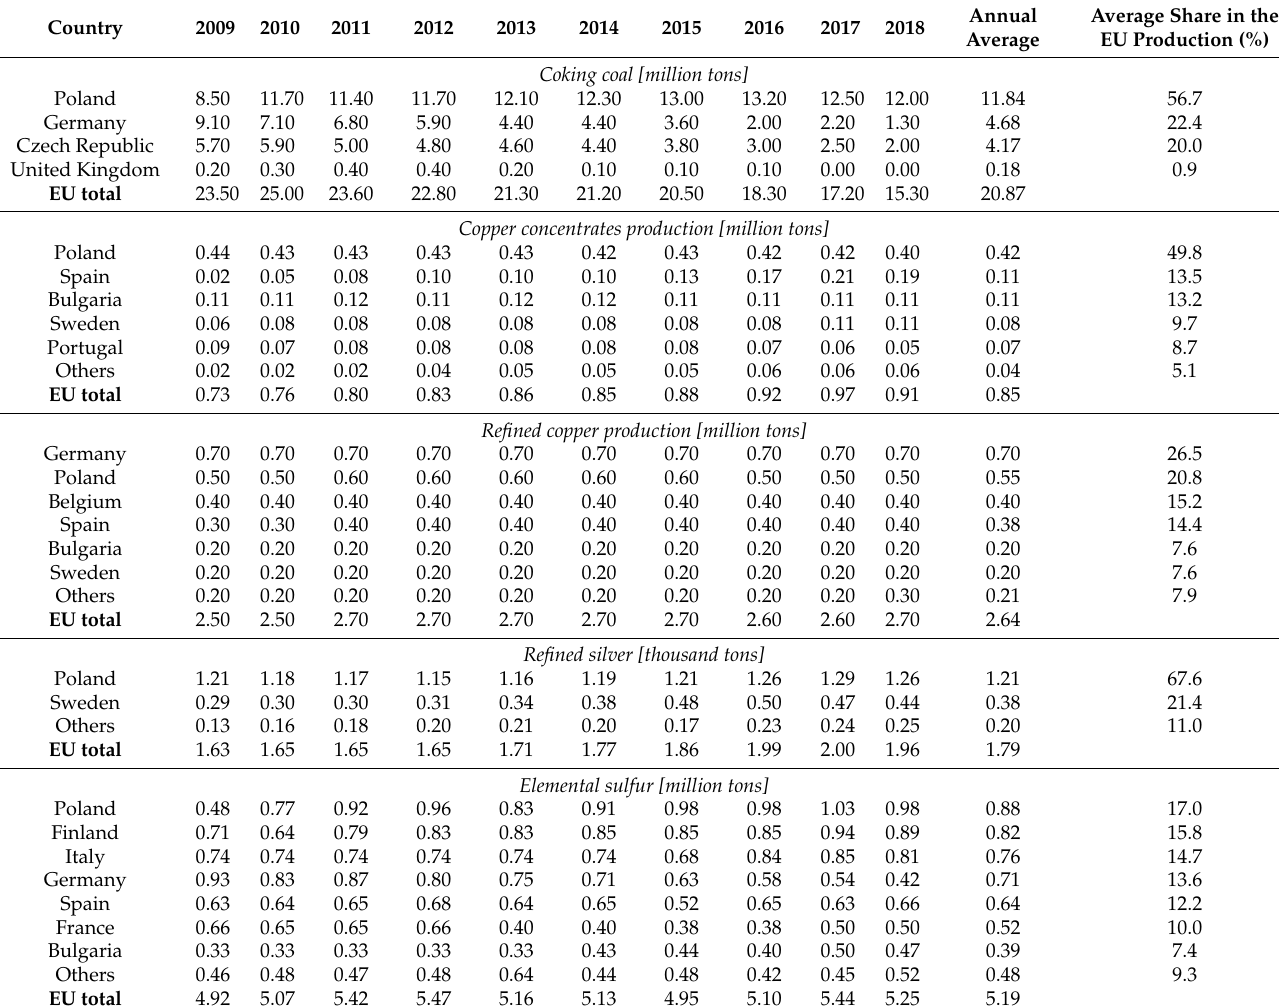
Table 1. Production of analyzed mineral raw materials in the EU countries in the years 2009–2018 [7–10].